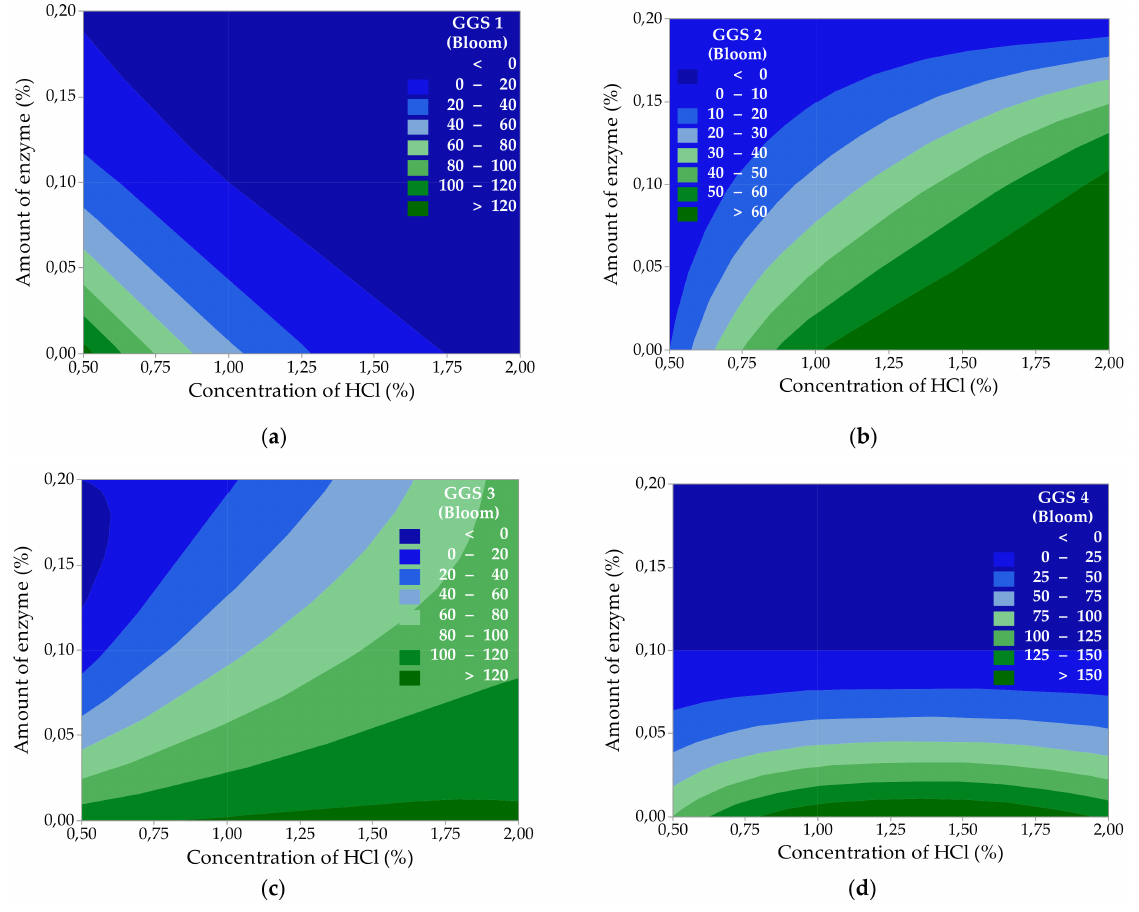
Figure 2. The influence of concentration of HCl and the amount of enzyme on gelatin gel strengths (GGS): ( a ) GGS of first gelatin fraction; ( b ) GGS of second gelatin fraction; ( c ) GGS of third gelatin fraction; ( d ) GGS of fourth gelatin